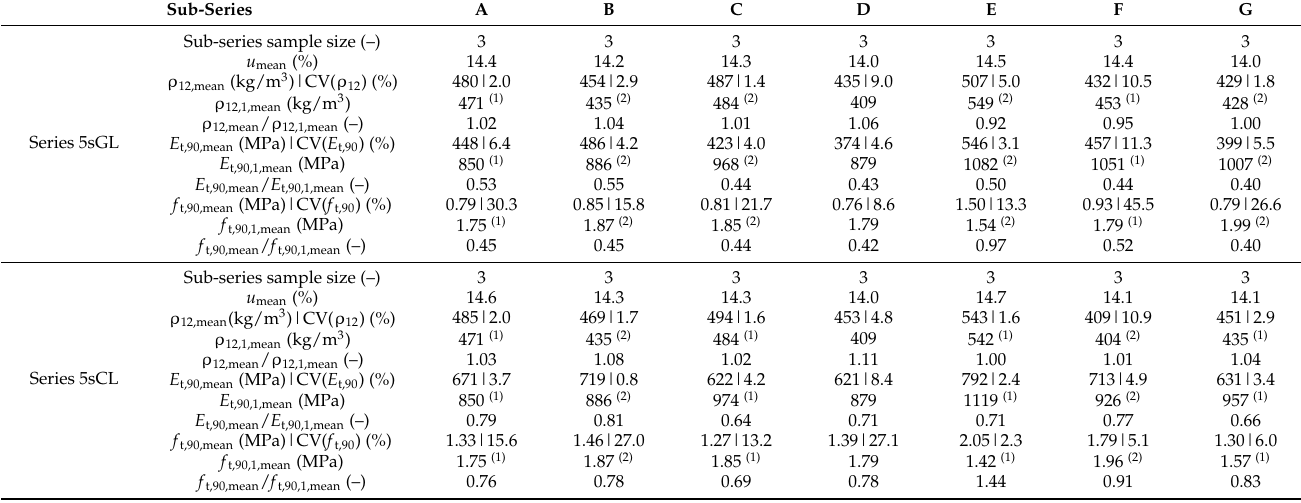
Table 9. Main statistics from sub-series data of series 5sGL (above) and series 5sCL (below) together with statistics from corresponding single board segment tests in series